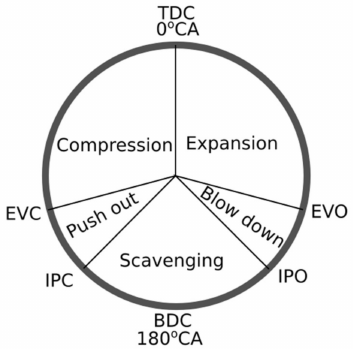
Figure 2. The uniflow scavenged two-stroke engine